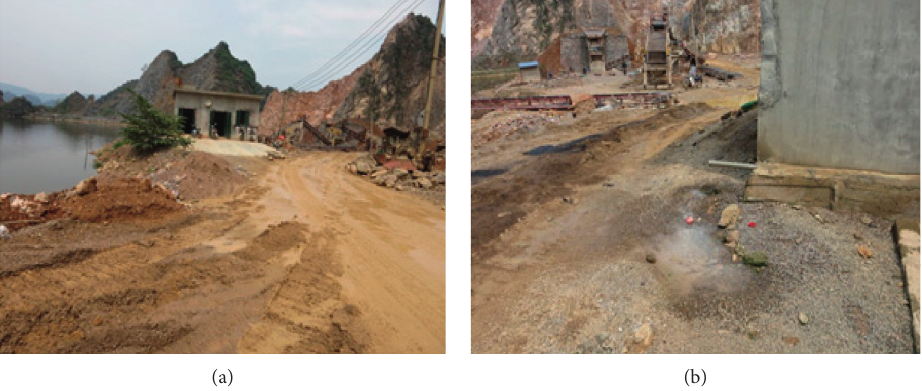
Figure 5: Sampling point in warehouse area (workers living